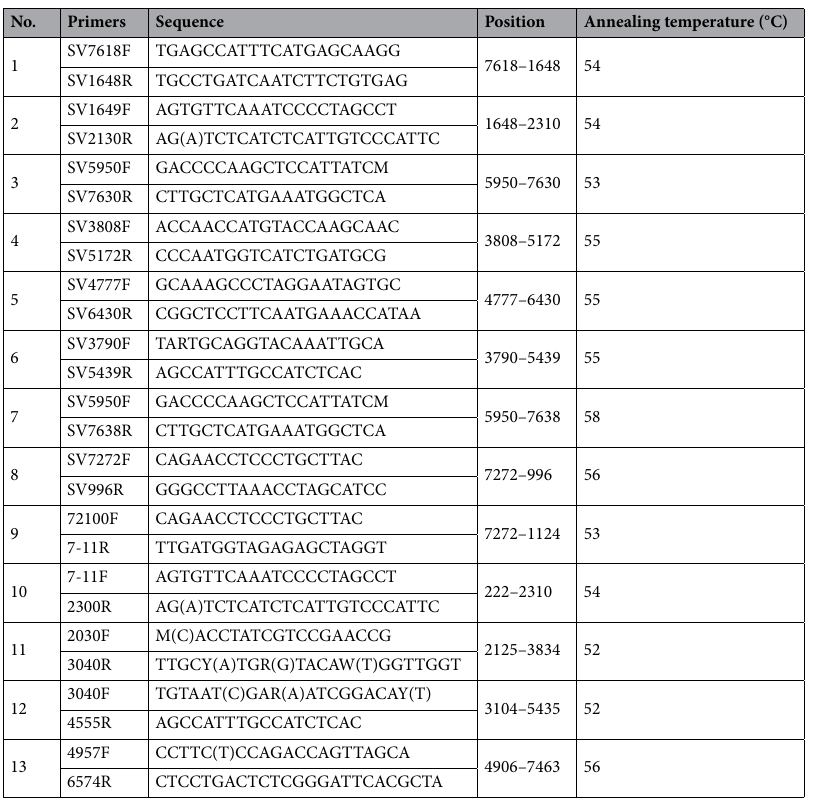
Table 1. Primers used for complete genome sequence of